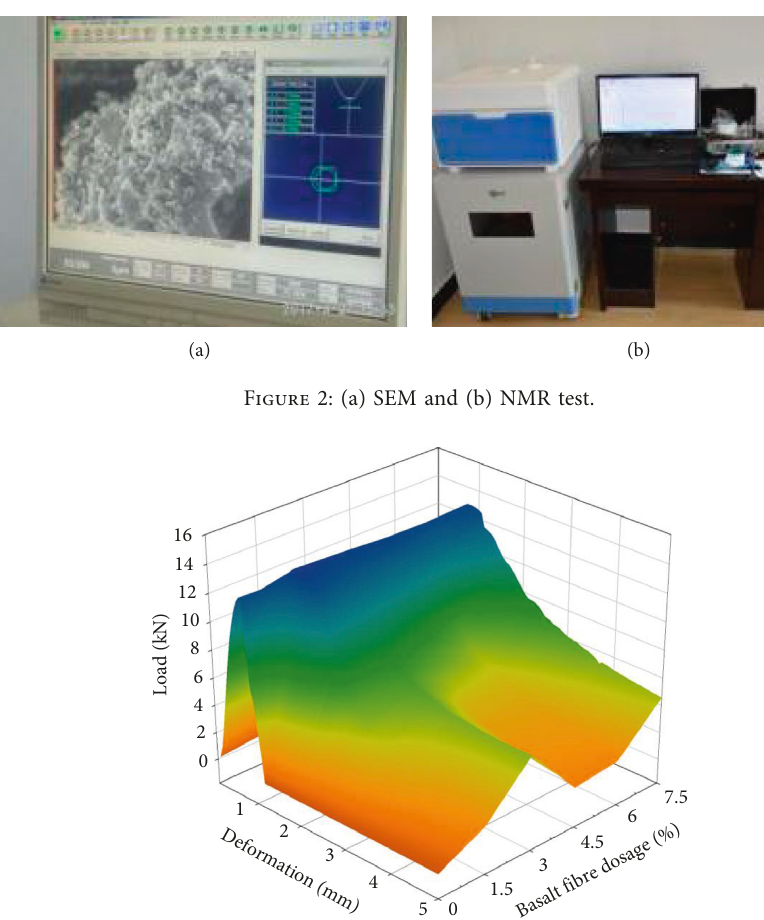
Figure 3: Load-strain curves of different